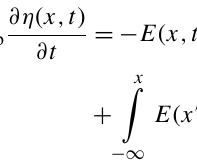
Figure 1. Diagram depicting angular particles dropped onto a sur- face inclined at angle θ where the frictional regime is collisional. Note the lack of sliding or rolling in this schematic. At each colli- sion between particle and surface some amount of energy associated with downslope motion is extracted. These values, denoted as β , in- volve interrelated x , y , and z components of motion. Due to the difference values of β for each collision, similar particles experi- ence unique paths of descent. The black and gray lines depict these varied